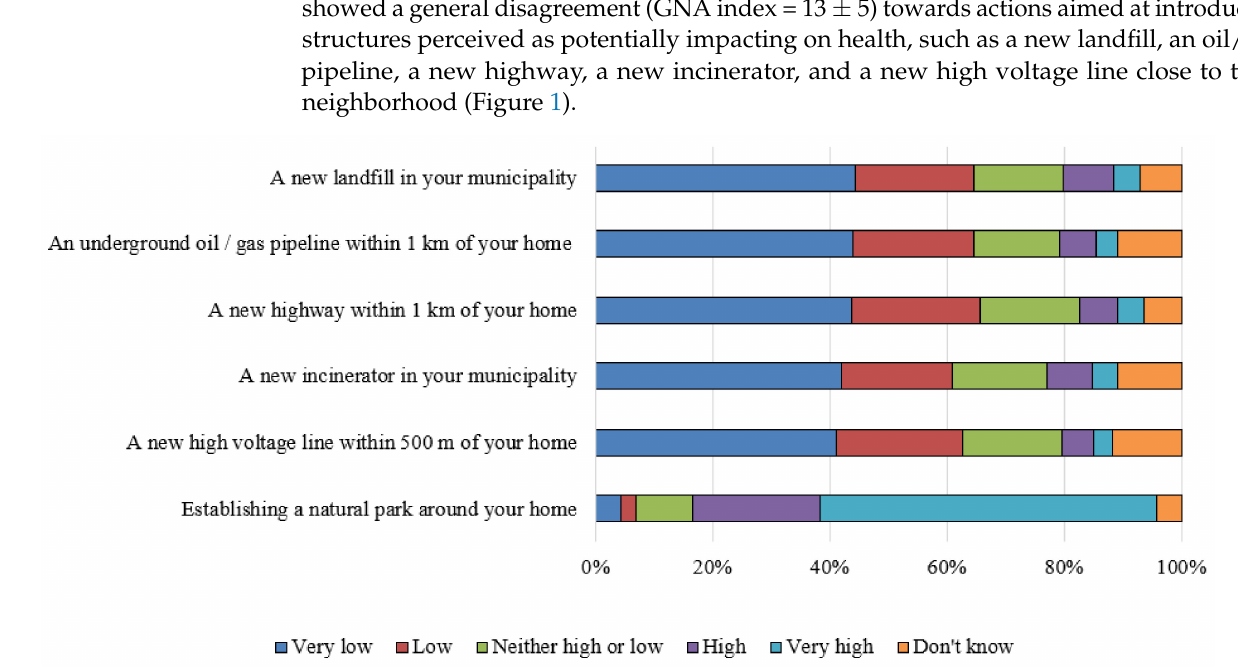
Figure 1. Level of potential support for environmental